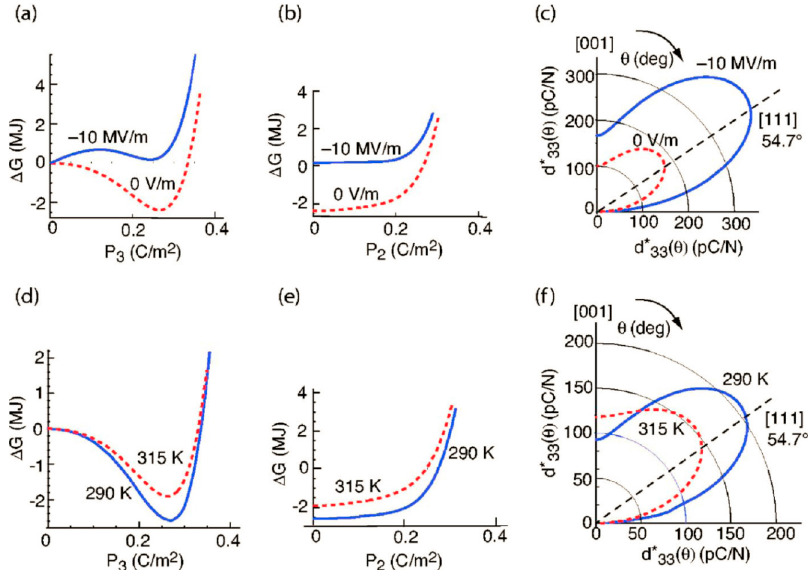
Figure 3. ( a – c ) The role of an electric bias field (E 3 = 0, − 10 MV/m) at T = 298 K on anisotropic free energy flattening and piezoelectric enhancement. ( d – f ) The change of anisotropic free energy and piezoelectric coefficient around the tetragonal-orthorhombic phase transition temperature in BaTiO 3 (which is adapted with permission from [30]. Copyrighted by the American Physical Society).